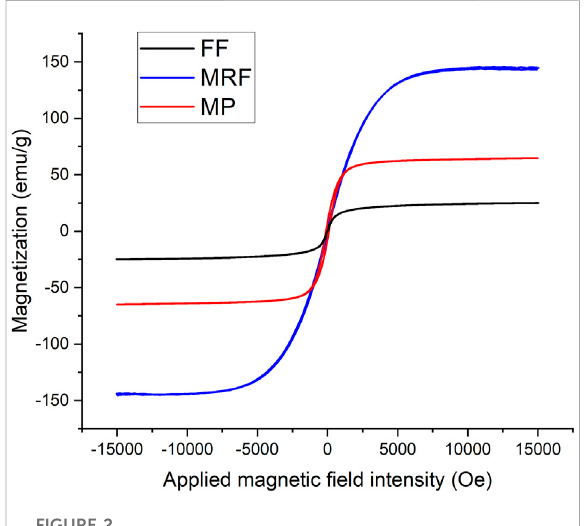
FIGURE 2 M-H curves of the FF, MRF, and MP at room